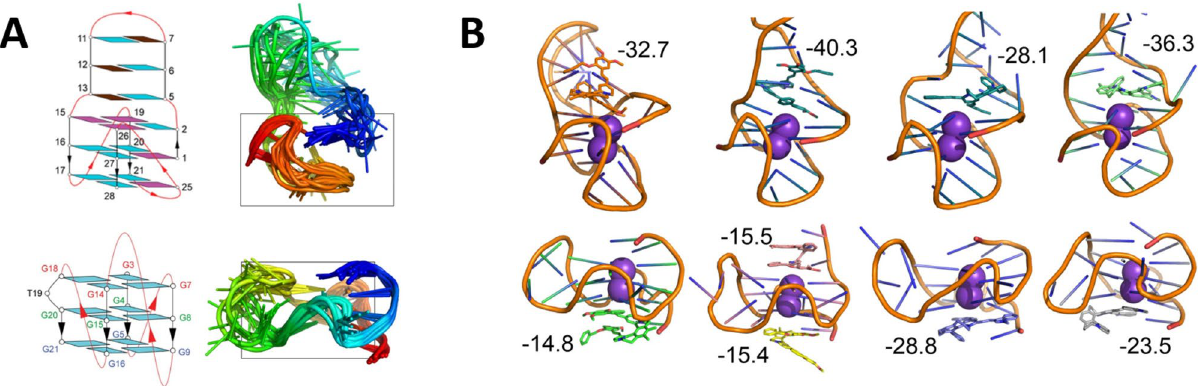
Figure 7.. ( A ) Structures of HIV-1 LTR-III (top; PDB: 6H1K) 38 and LTR-IV (bottom; PDB: 2N4Y) 50 G4s as determined by NMR. The structures are coloured in a rainbow pattern from the 5 ′ terminus (blue) to the 3 ′ terminus (red). ( B ) Computationally predicted most stable poses of 6 and 12 (in sticks) in LTR-III (top row) and LTR-IV (bottom row). G4s are shown as a cartoon, two K+ ions as magenta spheres. The compounds/ enantiomers are arranged from left to right: 6/ P, 6 /M, 12 /P, 12 /M. MM-GBSA binding free energies are shown in kcal/mol. For the enantiomer 6 /M, binding to LTR-IV, the iso-energetic poses are shown to be stacked on the top and bottom of the